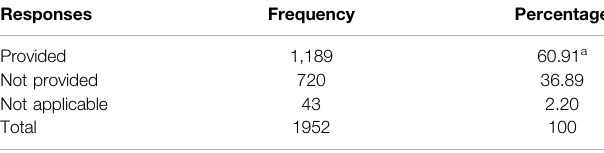
TABLE 3 | Provision of alternative/additional requirement (n (cid:1)